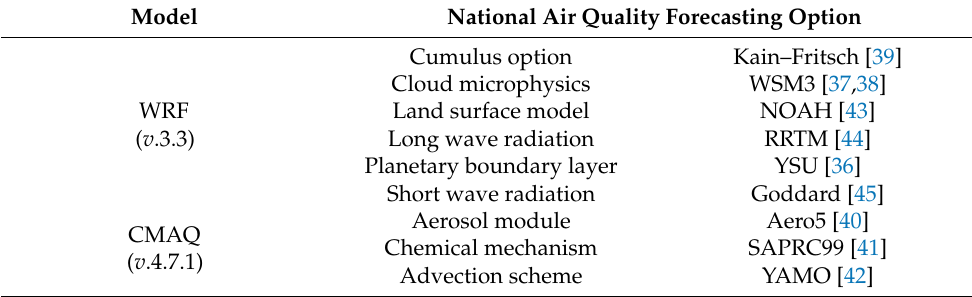
Table 1. Model conditions of the WRF/CMAQ